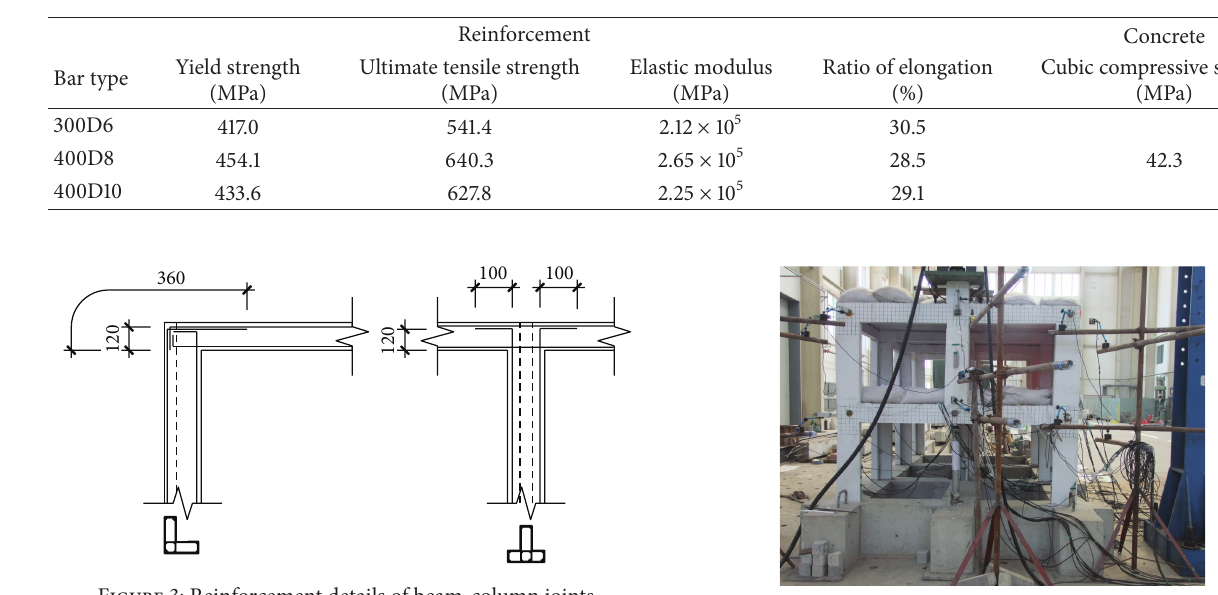
Figure 2: Section dimension and reinforcement details of beam and columns. (Note: R and T stand for steel bars with nominal yield strengths of 300 MPa and 400 MPa, resp.; the number following R or T represents the nominal diameter of a bar. @ stands for stirrup space. There is a decrease in spacing of stirrup by half of the near beam-column joint point according to Chinese seismic code.) Table 1: Material properties of steel bars and concrete.